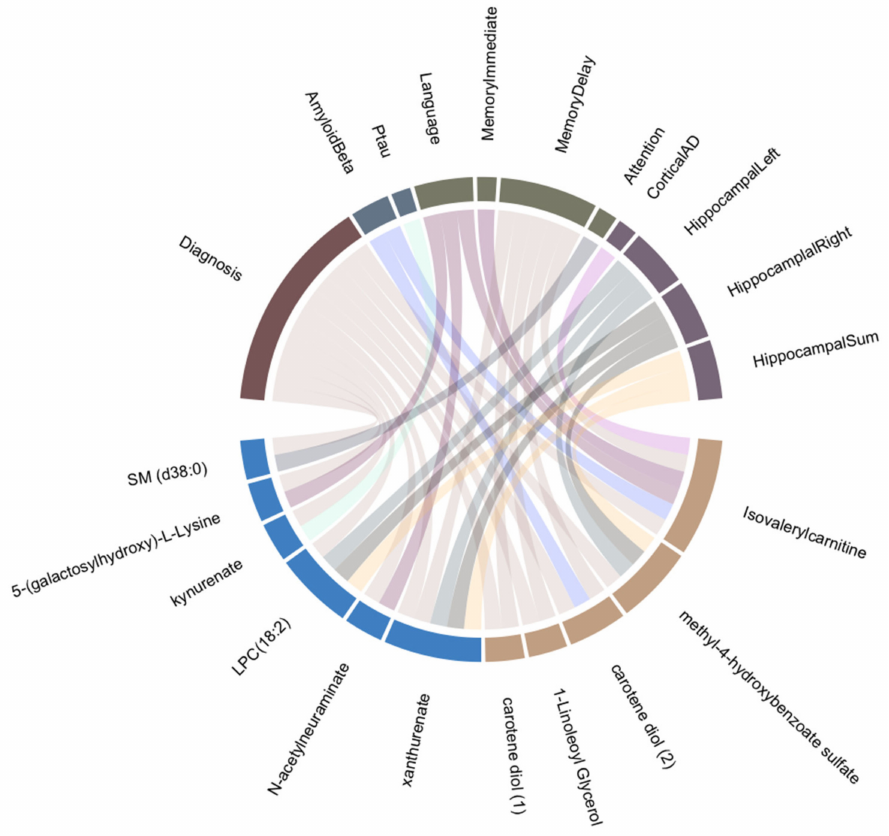
Figure 2. Eleven metabolites showed associations with AD and one other endophenotype. Five plasma metabolites (with brown grid), isovalerylcarnitine, methyl 4-, carotene diol (2), 1- linoleoyl glycerol and carotene diol (1), were significantly associated with diagnosis and the other AD endophenotypes in the female group only. Six other metabolites (with blue grid), xanturenate, N- acetylneuraminate, LPC (18:2), kynurenate, 5-(galactosylhydroxy)-L-lysine and SM (d38:0), showed associations with diagnosis and AD variables in the male group